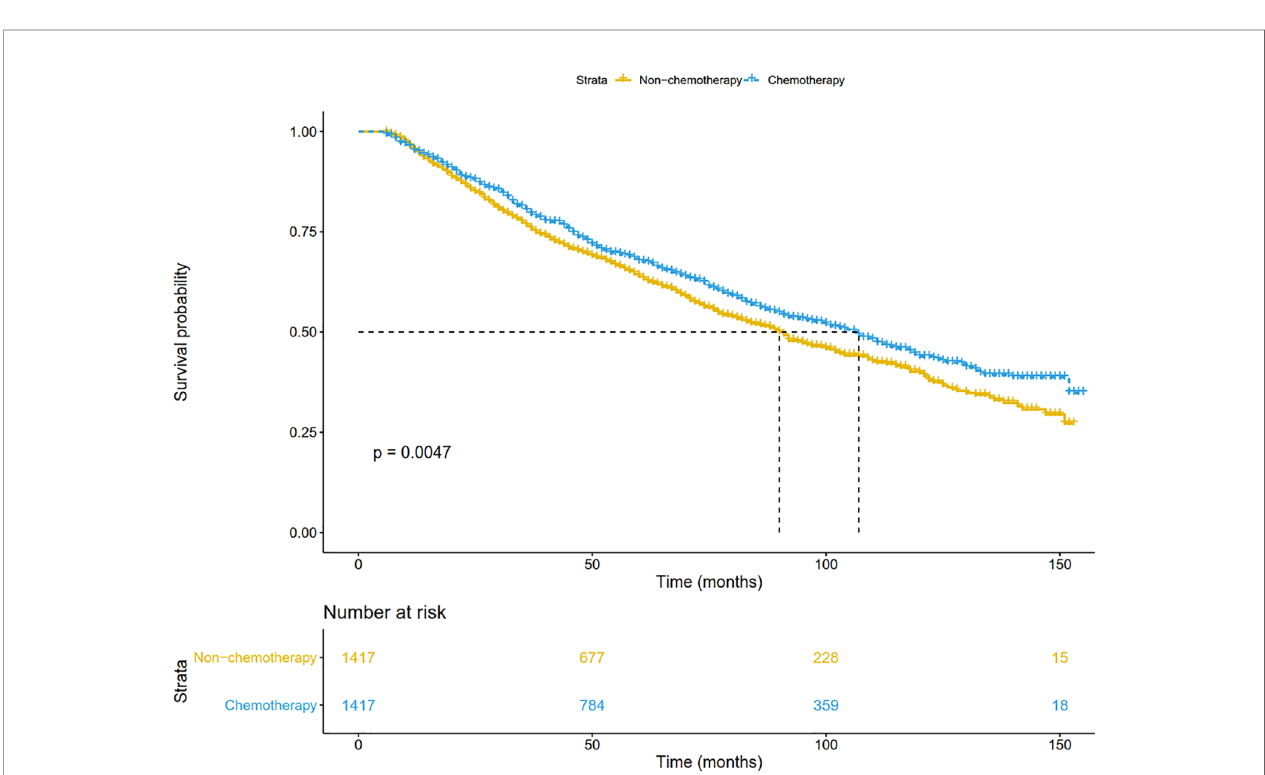
FIGURE 3 | Overall survival comparison by treatment arm for stage IB NSCLC patients in the SEER database cohort after PSM. PSM, Propensity score matching.